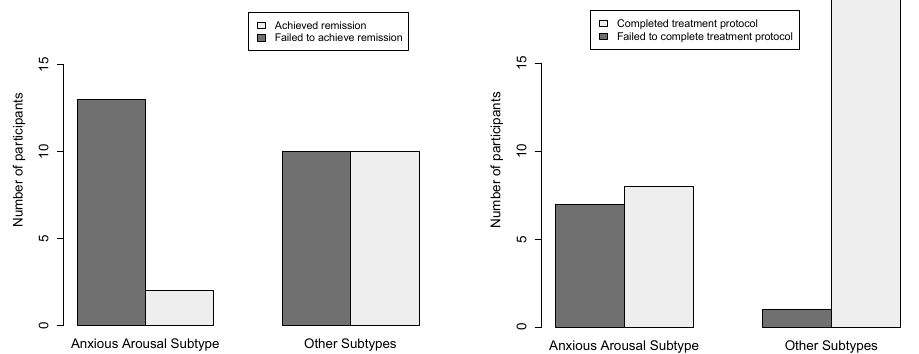
Figure 2. Left: After rTMS compared to all other subjects (FET, odds ratio 0.16, p = 0.034). This grouping predicted successful remitters with a sensitivity of 0.83, specificity of 0.56 and accuracy of 66%. Right: subjects in the anxious arousal subtype were also less likely to complete the treatment protocol (FET, odds ratio 0.066, p =